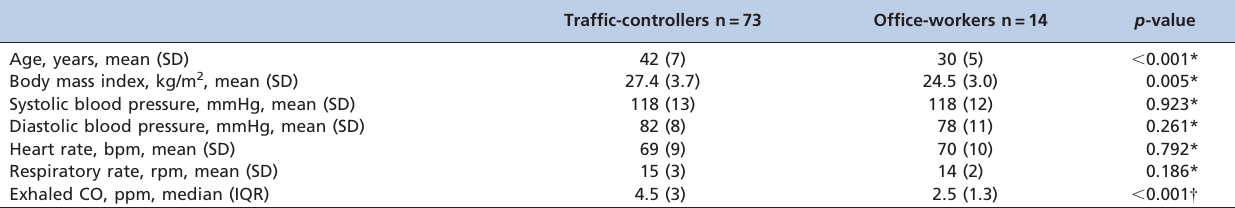
Table 1 - Demographic and clinical data of the street traffic-controllers and